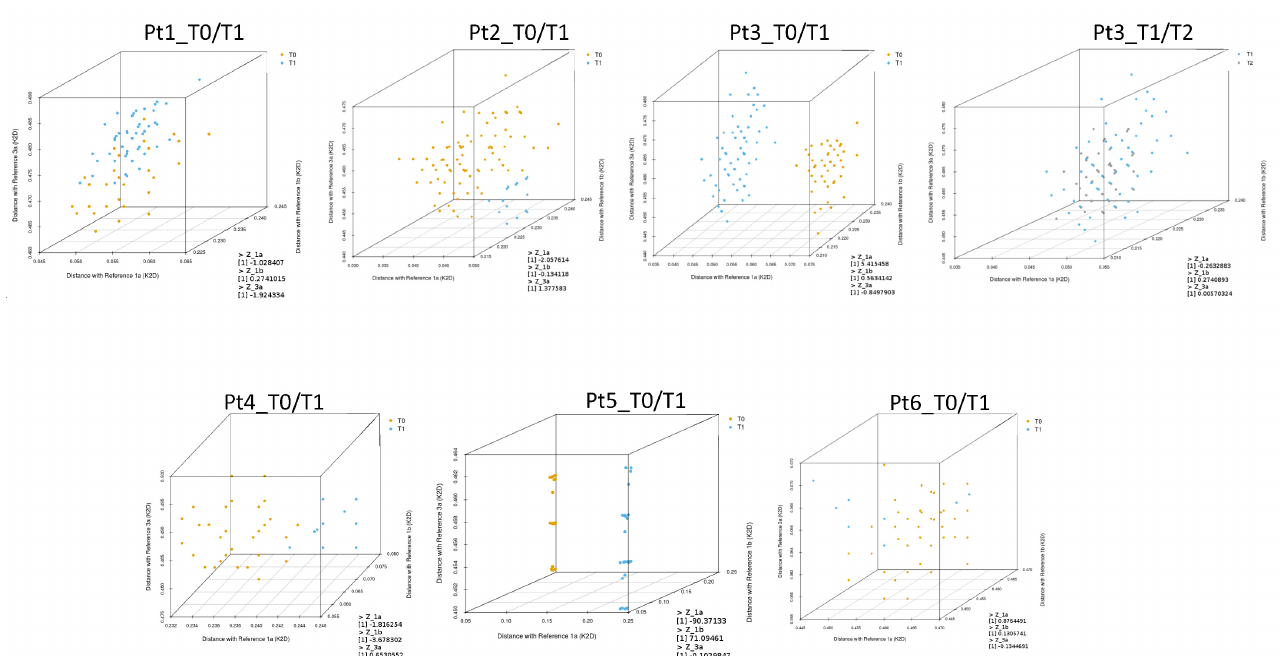
Figure 3. Three-dimensional plots illustrating genetic distances of quasispecies sequences with reference sequences representing GT1a (EF407457.1), GT1b (EU781827.1), and GT3a (X76918.1). Genetic distances between quasispecies sequences at T0, T1, and T2 are shown in orange, blue, and grey, respectively. Table 3. Z-scores absolute values; ZGT1a, ZGT1b, and ZGT3a are calculated for the same